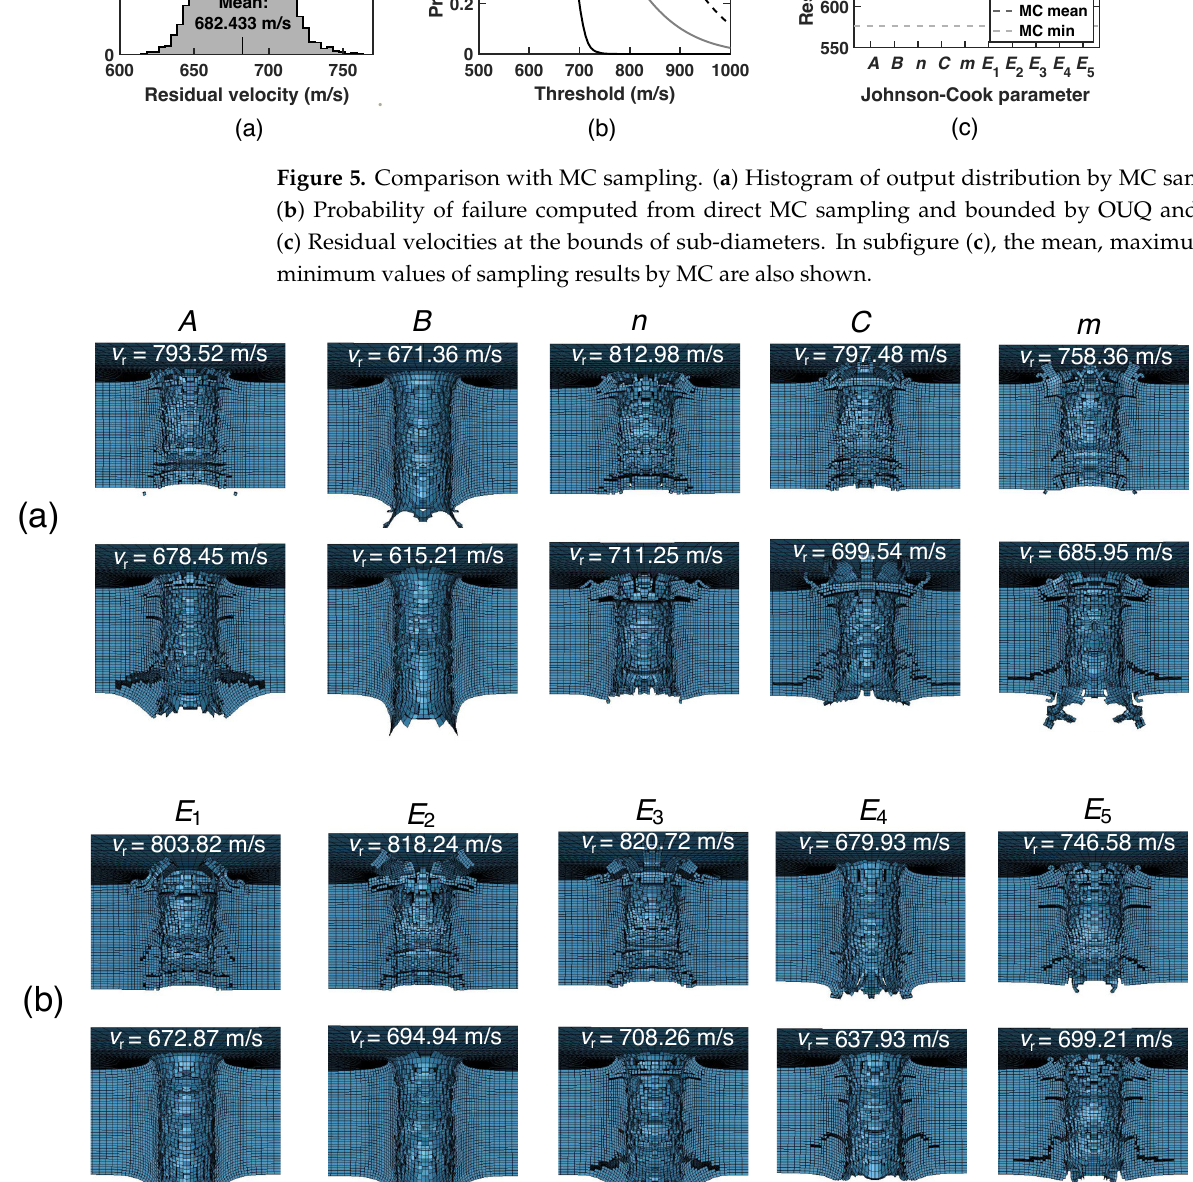
Figure 6. Snapshots of cavity after perforation at the bounds of sub-diameter for each random parameter. ( a ) Plasticity parameters. ( b ) Damage